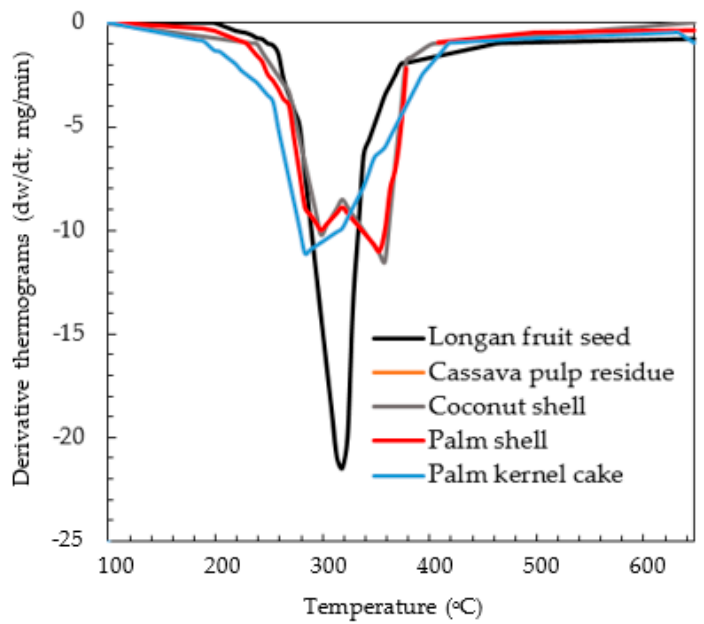
Figure 5. DTG curves of different biomass precursors used in the present study [25].